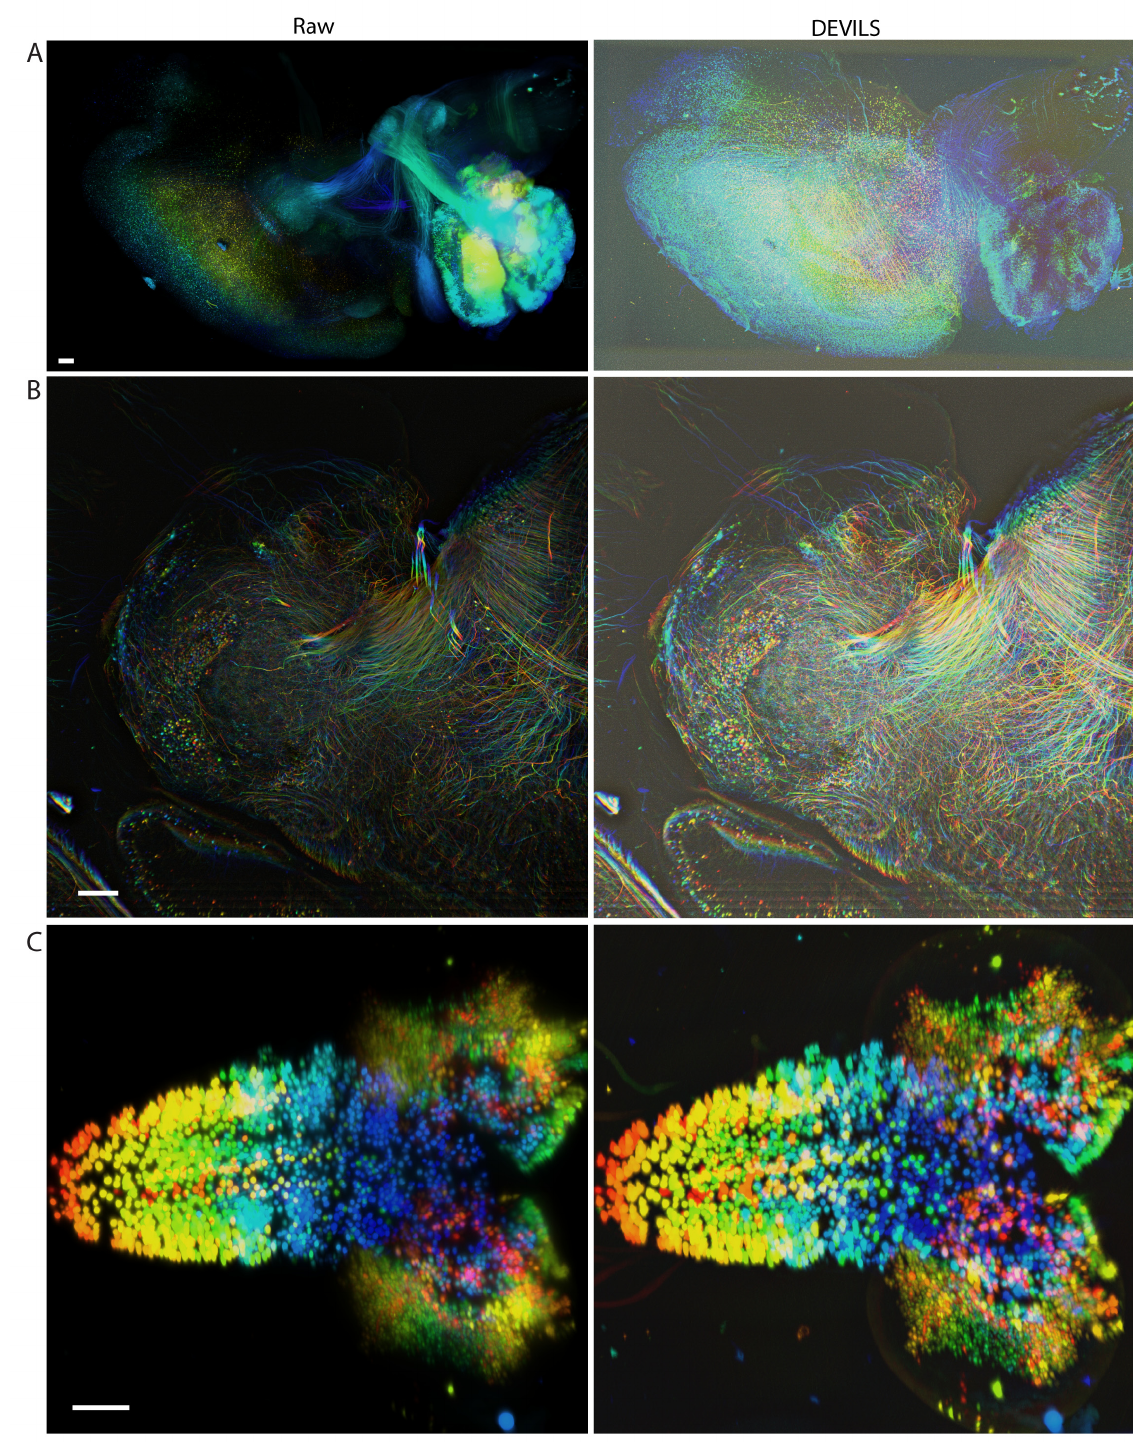
Figure 5. Example images of DEVILS processing. ( A ) Cleared mouse brain acquired with a mesoSPIM\0.8X. Comparison of raw and DEVILS processed images of a Z-color-coded projection using the “Physics” look-up table (LUT). The auto contrast was set on slice 600. Scale bar: 500 µm. ( B ) Cleared mouse brain acquired with a mesoSPIM\2.0X. Comparison of raw and DEVILS processed images of a Z-color-coded projection using the “Physics” LUT. The auto contrast was set on slice 600. Scale bar: 500 µm. ( C ) Drosophila brain acquired with light-sheet fluorescence microscopy (LSFM). Comparison of raw and DEVILS processed images of a Z-color-coded projection using the Physics LUT. The auto contrast was set on slice 380. Scale bar: 50